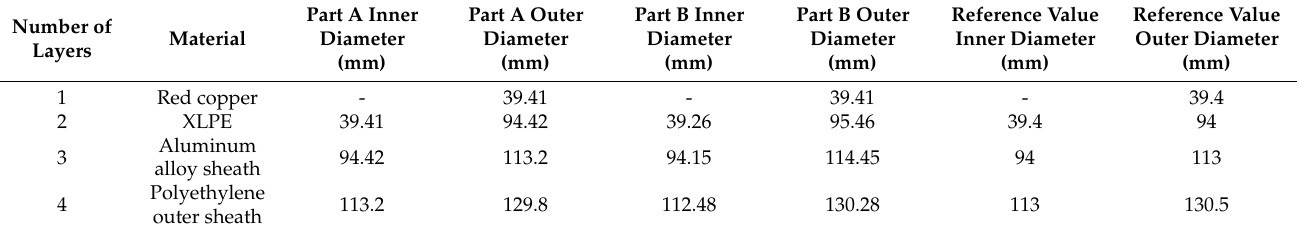
Table 3. Comparison between inner and outer diameters measured in Experiment 2 and the reference